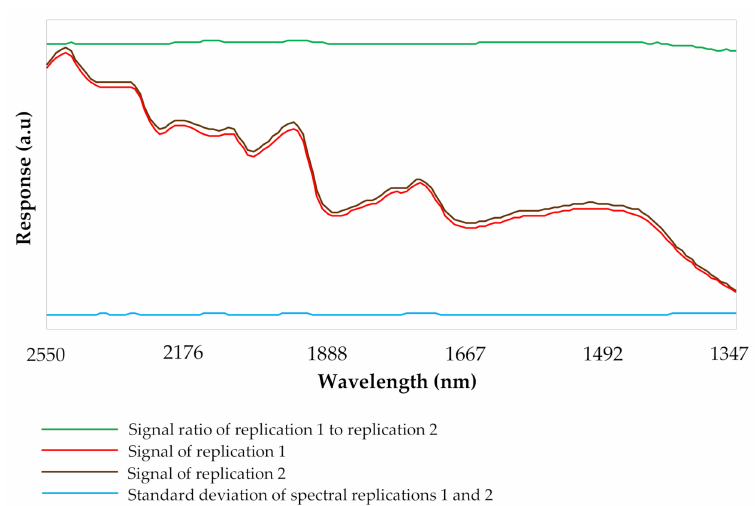
Figure A1. Noise level information by the signal ratio and taking the standard deviation of a random sample’s spectral replications and their corresponding spectra.